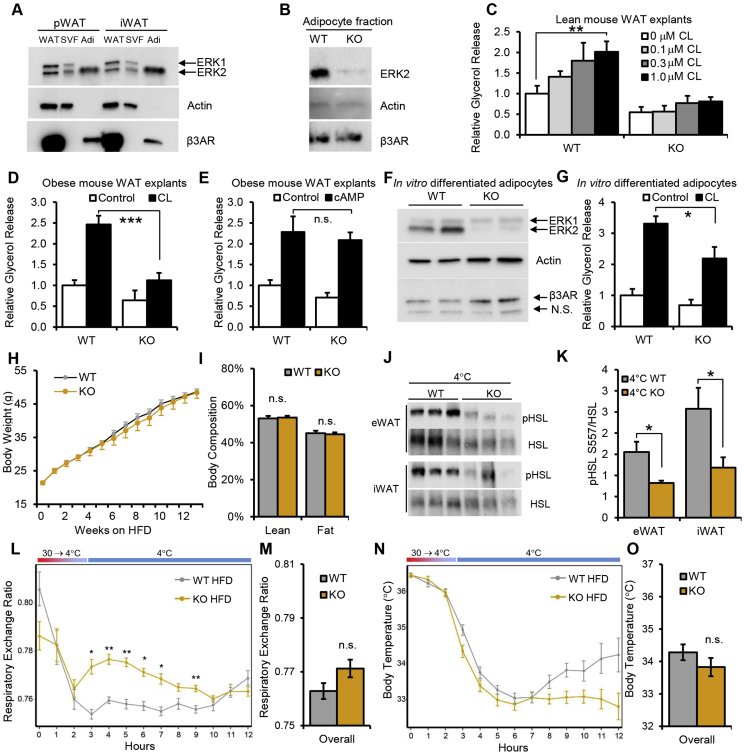
Mouse primary adipocytes exclusively express ERK2 and genetic adipocyte ERK2 deficiency impairs lipolysis. (A) ERK1 and ERK2 protein levels in mouse perigonadal WAT (pWAT) and inguinal WAT (iWAT). Comparison of whole tissue (WAT) and adipose tissue fractionated into SVF and floated primary adipocytes (Adi). Actin and β3AR proteins are preferentially expressed in SVF and adipocytes respectively. (B) ERK2 protein expressed in floated primary adipocytes isolated from wild type (WT) and ERK2AKO (KO) mice. (C) iWAT explants from lean WT and ERK2AKO (KO) mice were treated with 0 μM, 0.1 μM, 0.3 μM and 1 μM of selective β3AR agonist CL-316,243 (CL). (D,E) Glycerol release in iWAT explants from obese wild type (WT) and ERK2AKO (KO) mice treated with (D) 1 μM CL or (E) 0.5 mM 8-Br-cAMP (cAMP). ERK1 and ERK2 protein expression (F) and CL-induced glycerol release (G) from in vitro differentiated adipocytes derived from WT and ERK2AKO (KO) mice. (H) Average body weight of WT and ERK2AKO (KO) mice (n = 9 per genotype) on HFD. (I) Body composition represented as percent body fat mass and percent lean mass in WT and ERK2AKO (KO) mice on HFD (n = 9 per genotype). (J and K) Phosphorylation of HSL at Ser557 following a 3-hr cold exposure in eWAT and iWAT (J) Western blotting and (K) band quantitation analysis by one-tailed Student's t-test. (L–O) Indirect calorimetry measurements of WT and ERK2AKO mice (KO) (n = 9 per genotype) when challenged with cold exposure. The average Respiratory Exchange Ratio (L, M) and body temperatures were plotted (N, O). Error bars represent SEM. Statistical significance was analyzed by one-way ANOVA. n.s., p > 0.005; *, p < 0.005; **, p < 0.01.